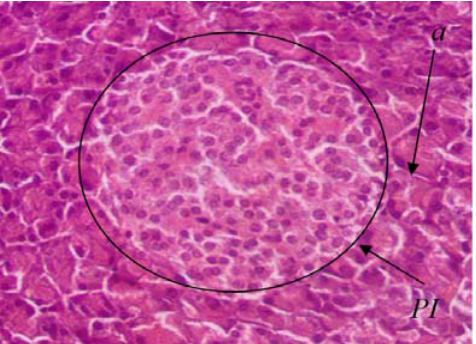
Fig. 1. The pancreas of intact Syrian hamster. You can see numerous acinus (a) and pancreatic islet (PI), evenly filled with cells whose nuclei differ in size and degree of color